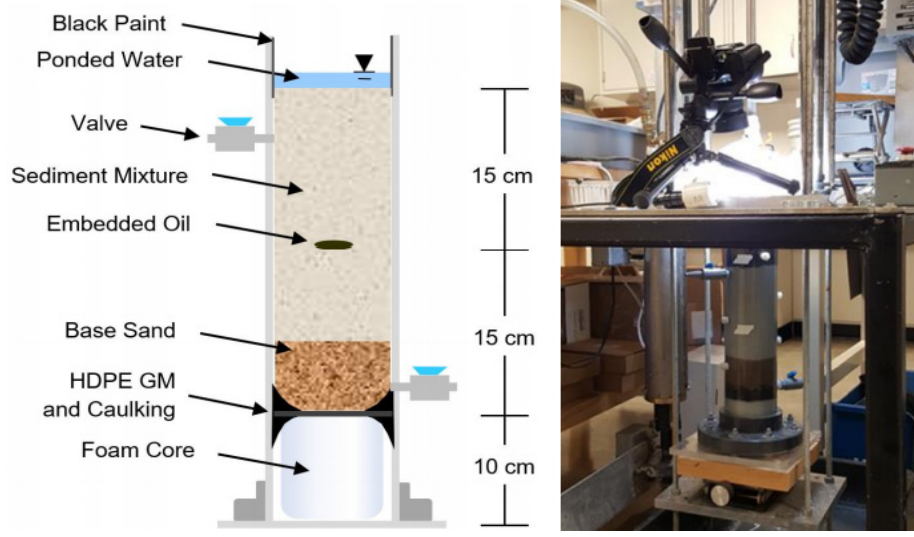
Figure 1. Schematic of water-sediment column experimental design including the lighting and image collection in the laboratory OS-SS setup.